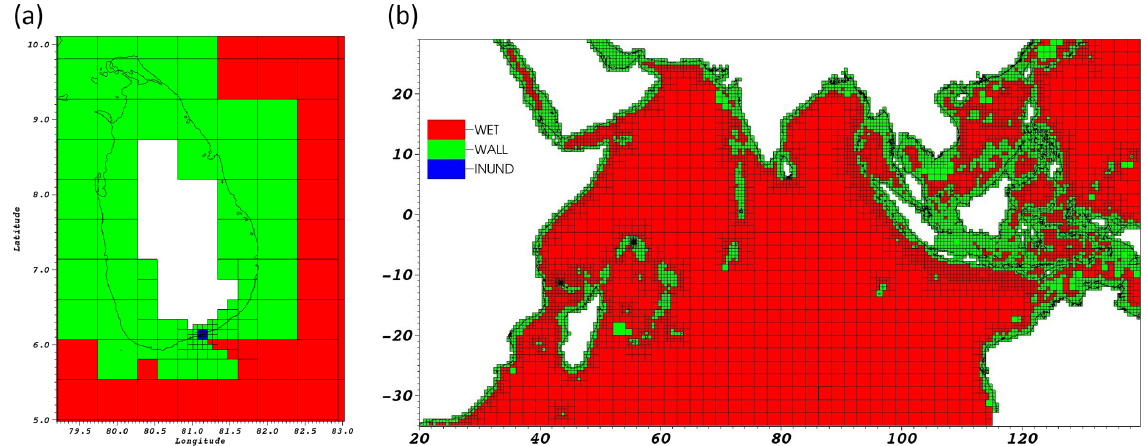
Figure 8. Mesh blocks colored by kernel type: Wet, Wall and Inundation. (a) Zoom over Sri Lanka FA to highlight the inundation kernels shaded in blue. (b) Kernel type distribution on the entire Indian